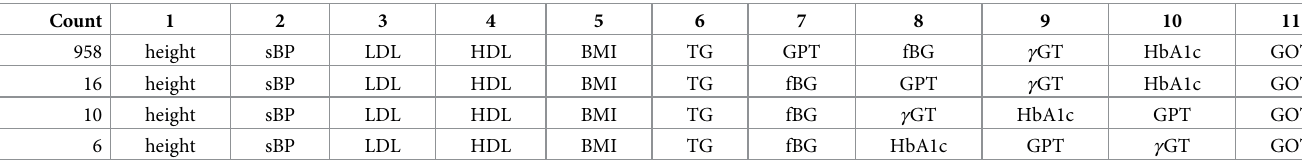
The four frequent orders of indices appearing in our analysis are listed from the top to the bottom rows. The indices are arranged from the earliest to the latest in each causal order from left to right